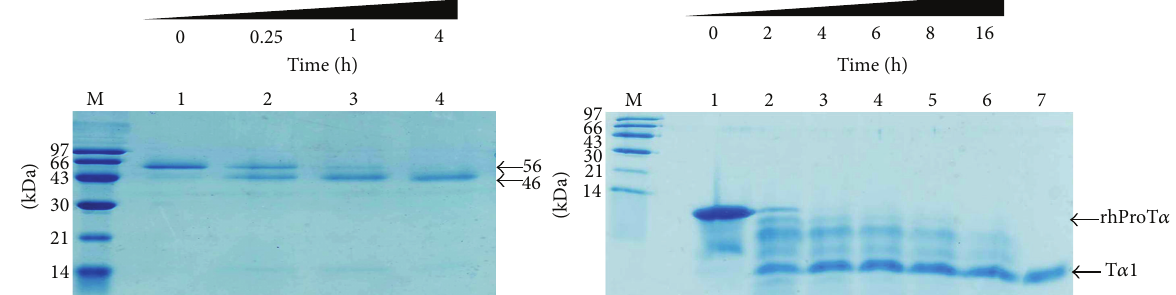
Figure 2: (a) Expression and purification of legumain in P. pastoris and its autoactivation. SDS-PAGE of autocatalytic legumain after the prolegumain was incubated in buffer as a function of time (0–4 h) at 37 ∘ C. Aliquots of each reaction were analyzed by SDS-PAGE (12%) and stained with Coomassie blue. Each time point is marked on the bottom of its corresponding lane. (b) SDS-PAGE analysis of Prothymosin 𝛼 proteolysis by recombinant legumain in vitro . Aliquots of ProT 𝛼 were incubated with recombinant legumain at 37 ∘ C in buffer containing 1mMDTT,1mMEDTA,and0.1 Msodiumcitrate(pH4.0).EachreactionmixturewasanalyzedbySDS-PAGEundertheconditionsindicated under “Experimental Section.” Each time point is marked on the bottom of its corresponding lane 1–6. Lane 7 is the chemically synthesized N 𝛼 -acetylated T 𝛼